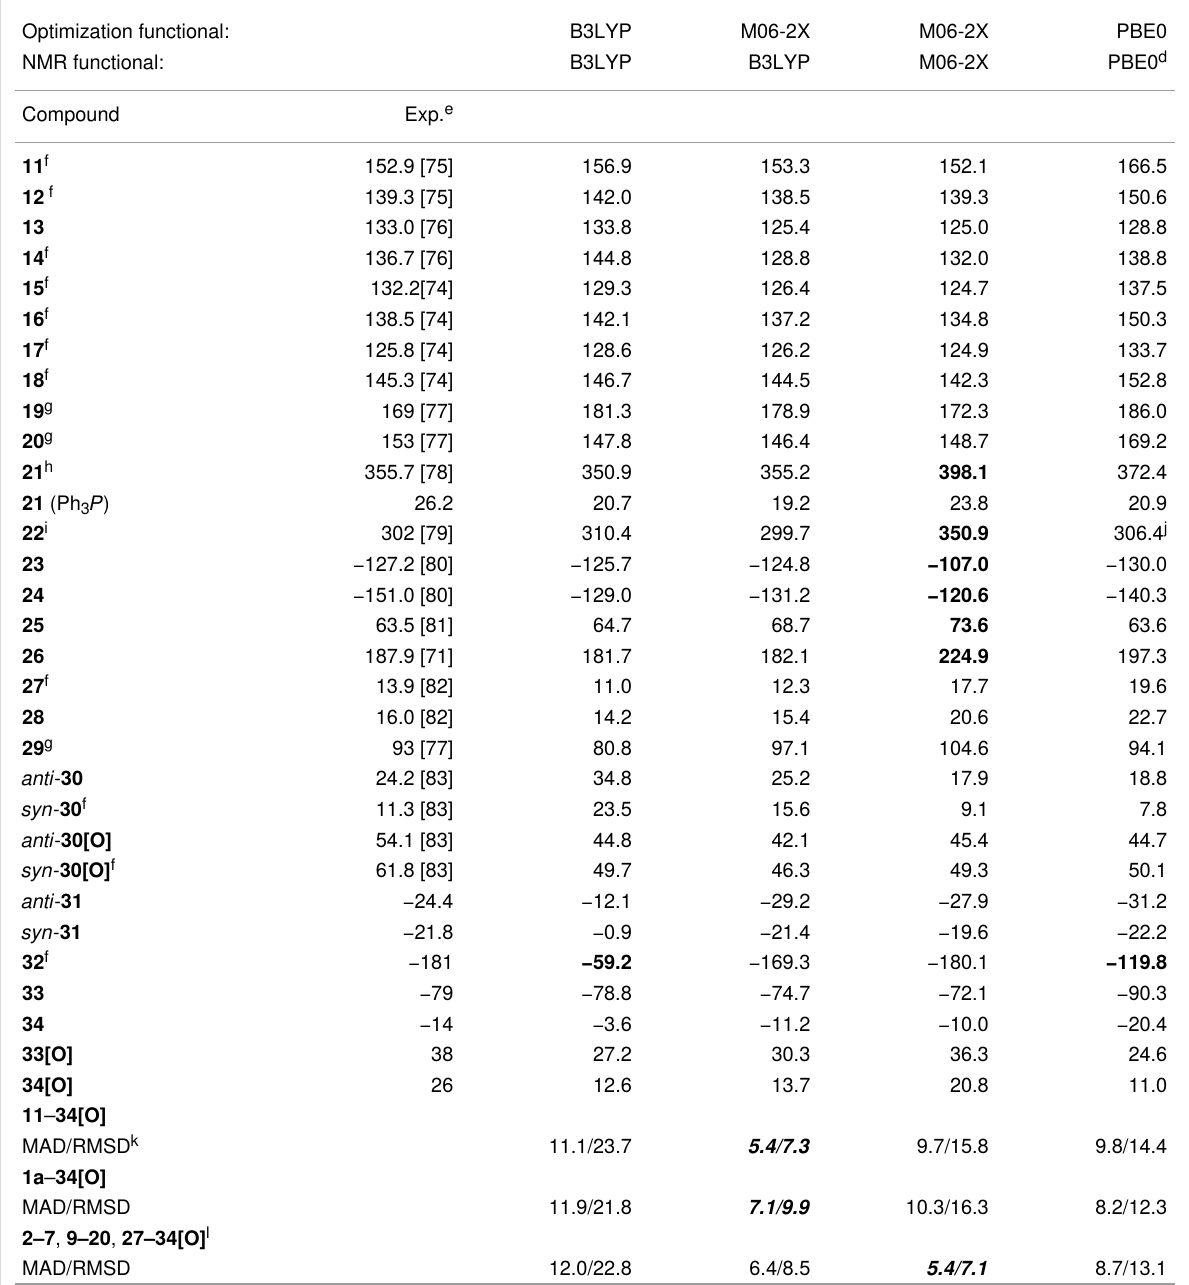
Table 3: Experimental a and scaled b 31 P NMR chemical shifts c for the compounds shown in Figure 5, Figure 6, and Figure 7.